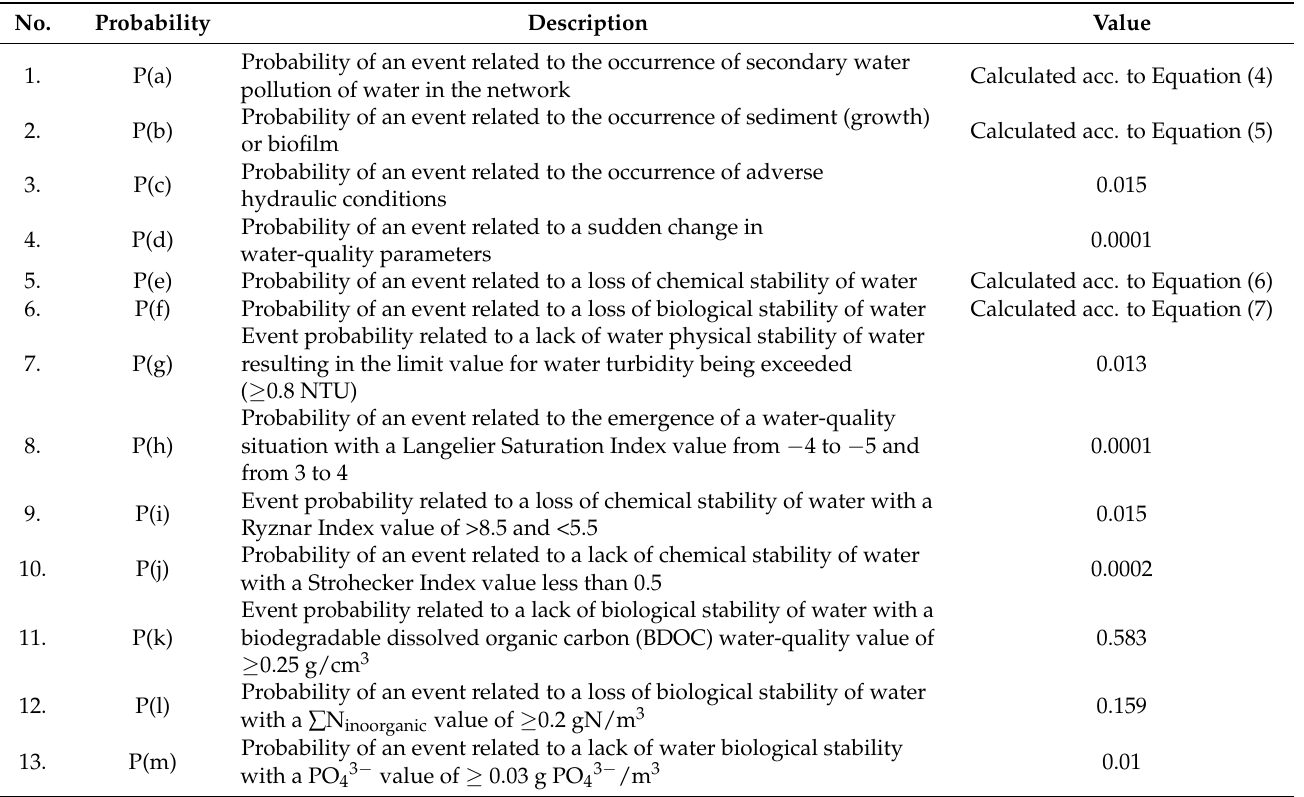
Table 2. Probabilities of occurrence of specific